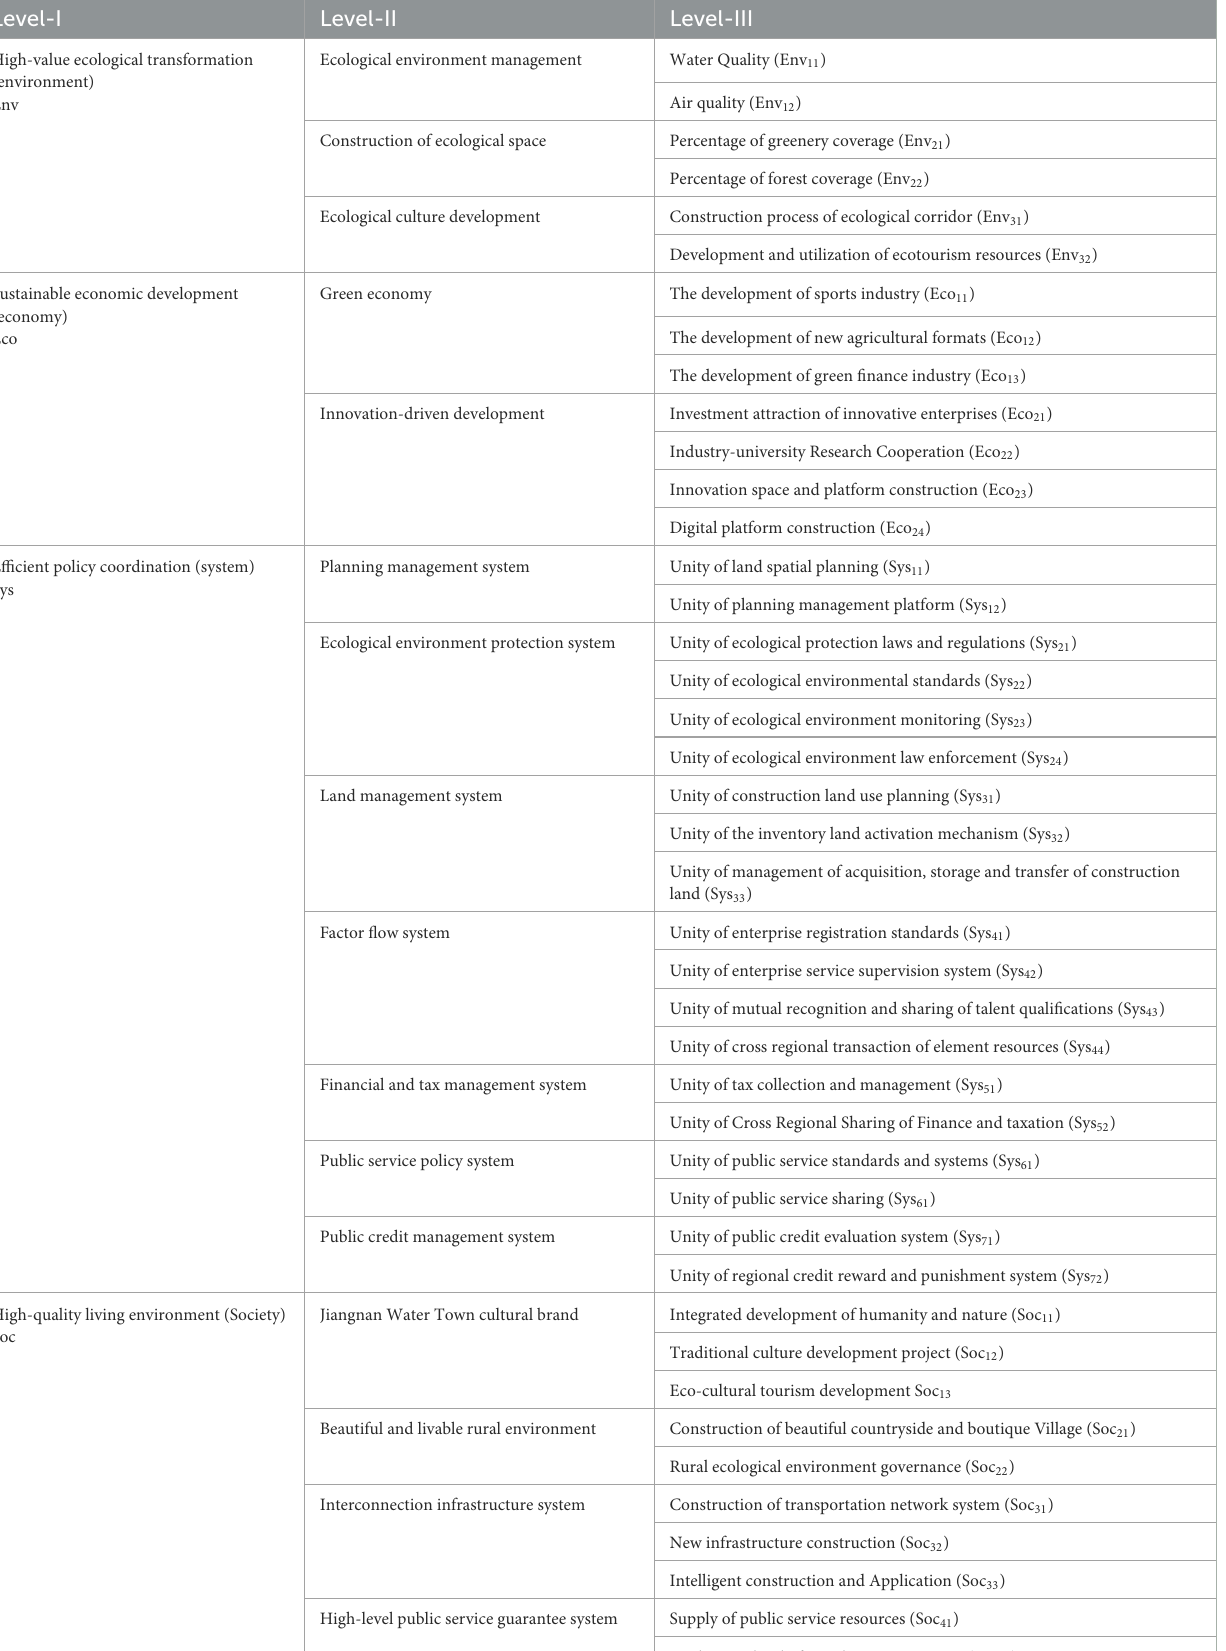
TABLE 1 High-quality development evaluation indicators of Yangtze River Delta ecological green integrated development demonstration